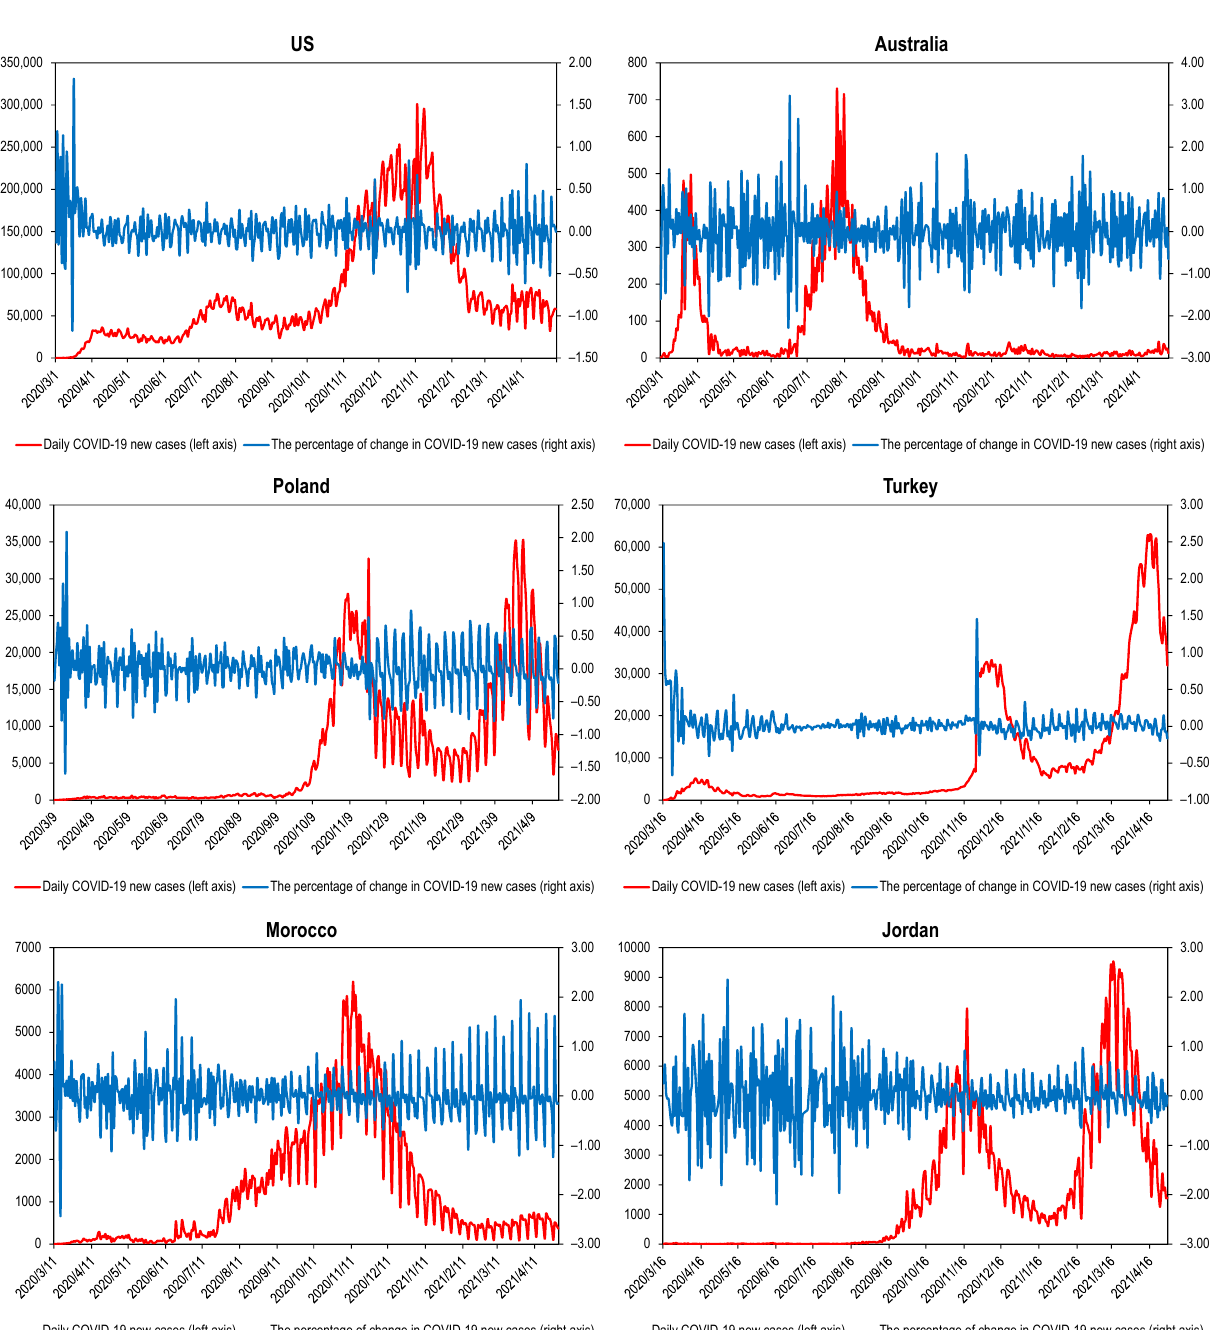
Figure 1. The development of COVID-19 in the studied